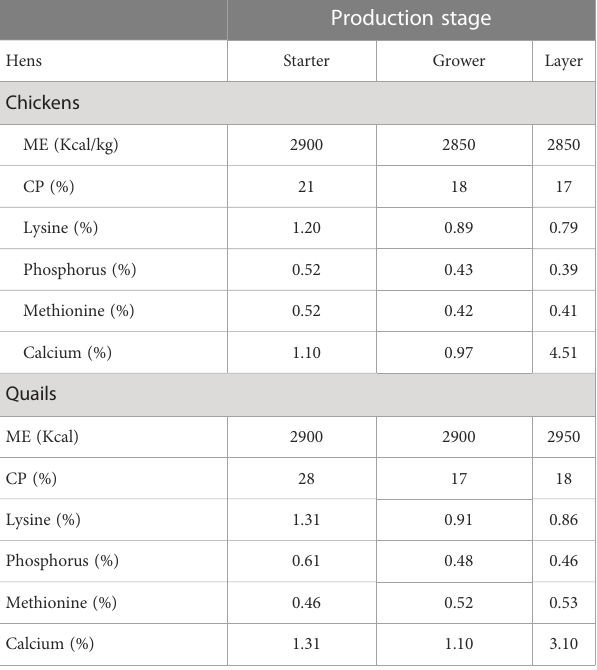
TABLE 1 Nutritional requirements of quail and chicken hens at different production